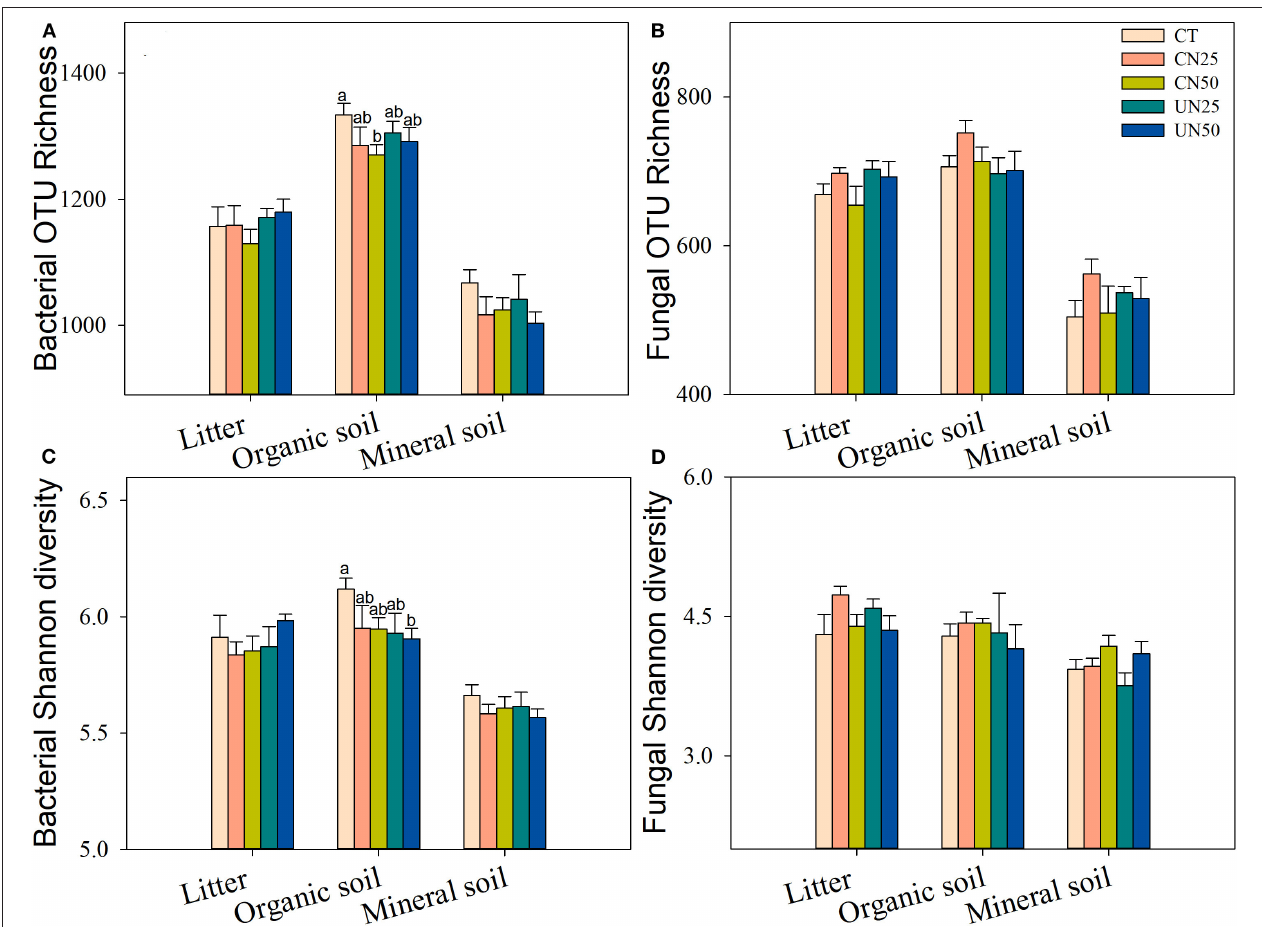
FIGURE 2 | Effects of N addition treatments on soil bacterial (A,C) and fungal (B,D) alpha-diversity in different soil layers. Values are means ± standard error. Within each group of five treatments, values with different letters represent significant differences among the five treatments ( LSD test, P < 0.05). CT, control without N addition; CN25, canopy N addition with 25kg N ha − 1 year − 1 ; CN50, canopy N addition with 50kg N ha − 1 year − 1 ; UN25, understory N addition with 25kg N ha −